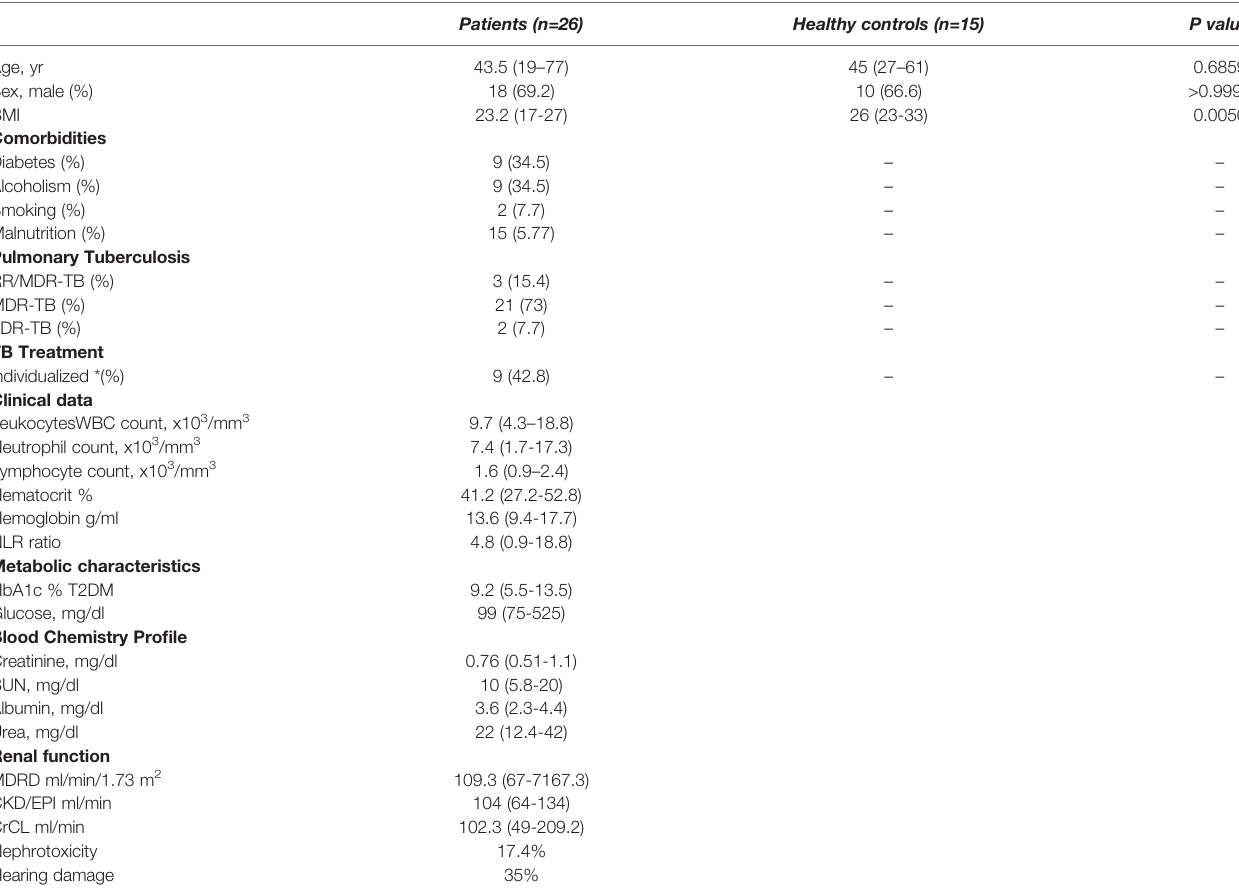
TABLE 1 | Characteristics of the study